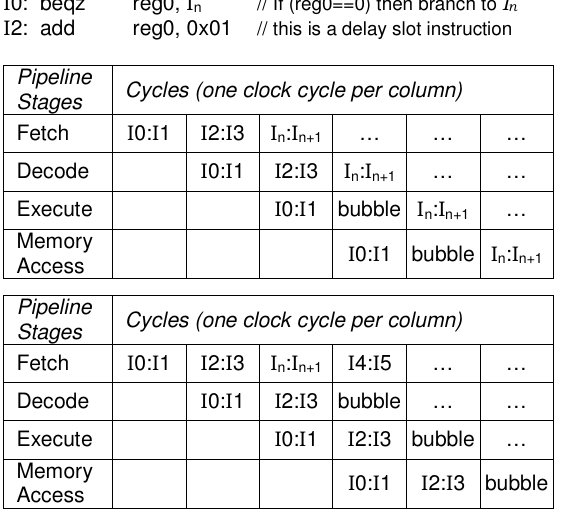
Figure 15. Example of (top) a correctly predicted and (bottom) a mispredicted branch